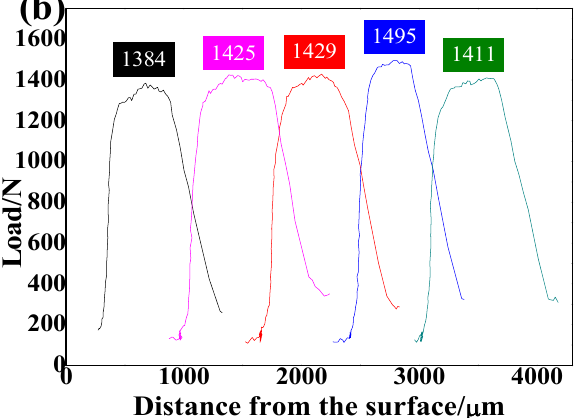
Figure 13. Shear stress-displacement curve ( a ) substrate; ( b ) cladding layer.